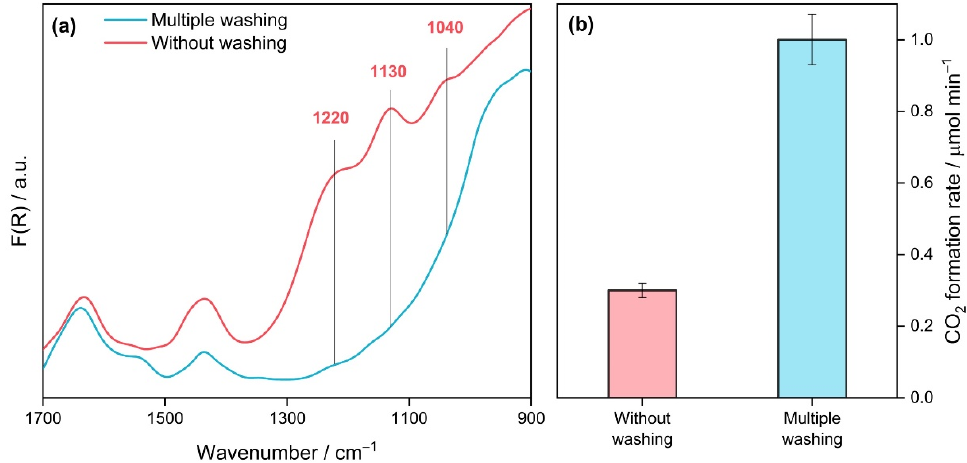
Figure 7. DRIFT spectra ( a ) and photocatalytic activity ( b ) of TiO 2 -N samples (350 °C) with and without intermediate washing of the precipitate.